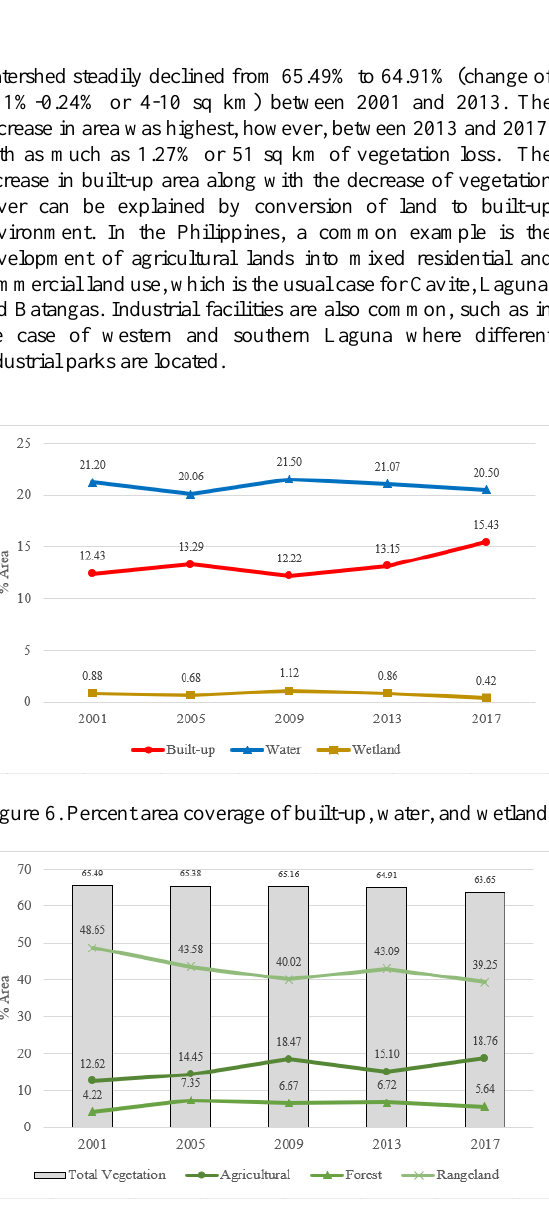
Figure 7. Percent area coverage of vegetation cover